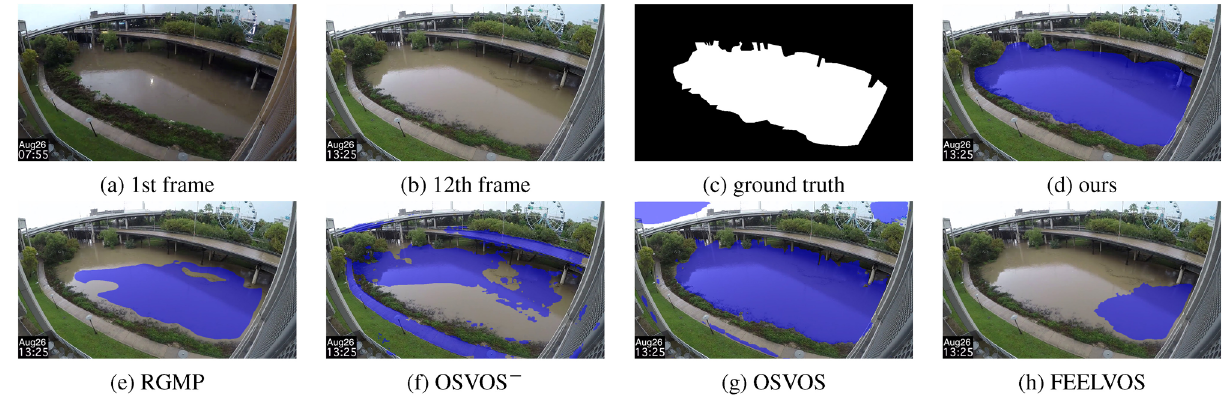
Fig. 6 Qualitative results from test video “buffalo0”: (a) 1st frame, (b) 12th frame for segmentation, (c) ground-truth water, (d)–(h) segmentations of WaterNet, RGMP, OSVOS without online training, OSVOS, and